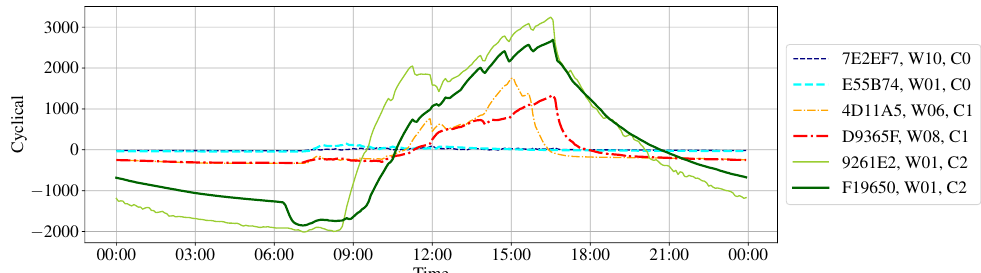
Figure 21. Cyclical component cluster result sample.